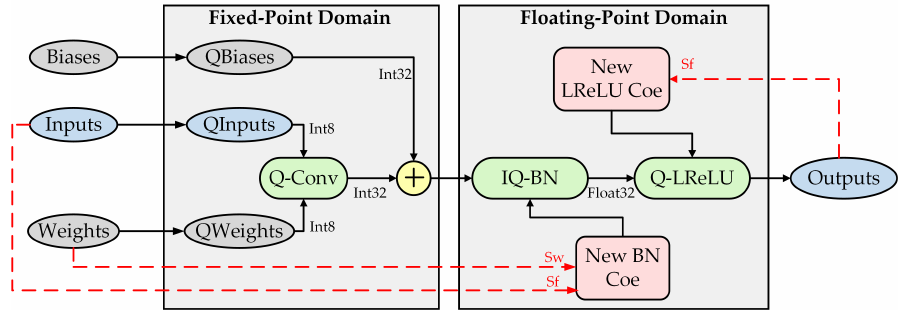
Figure 5. The flow chart of operation integration.